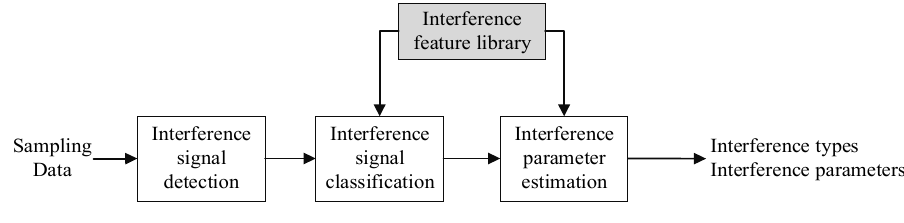
Figure 2. Interference monitoring process.